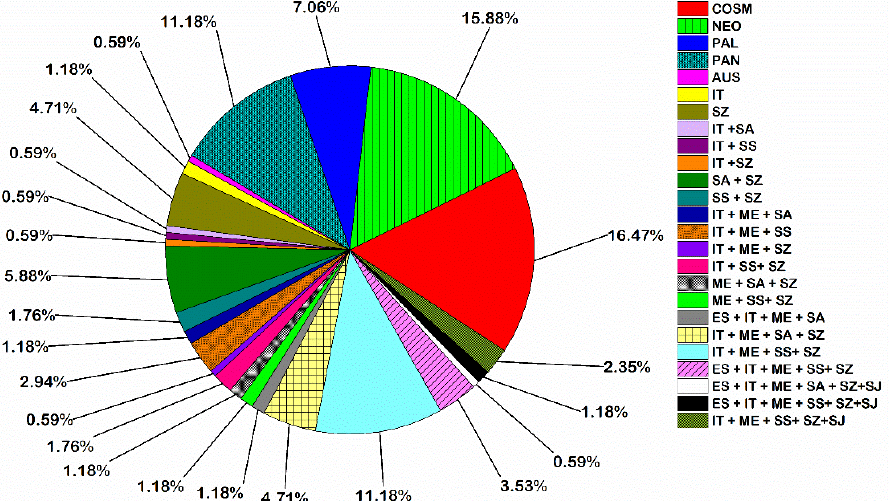
Figure 2. Phytogeographical analysis of plant species recorded in the Aswan Reservoir area. Cho-